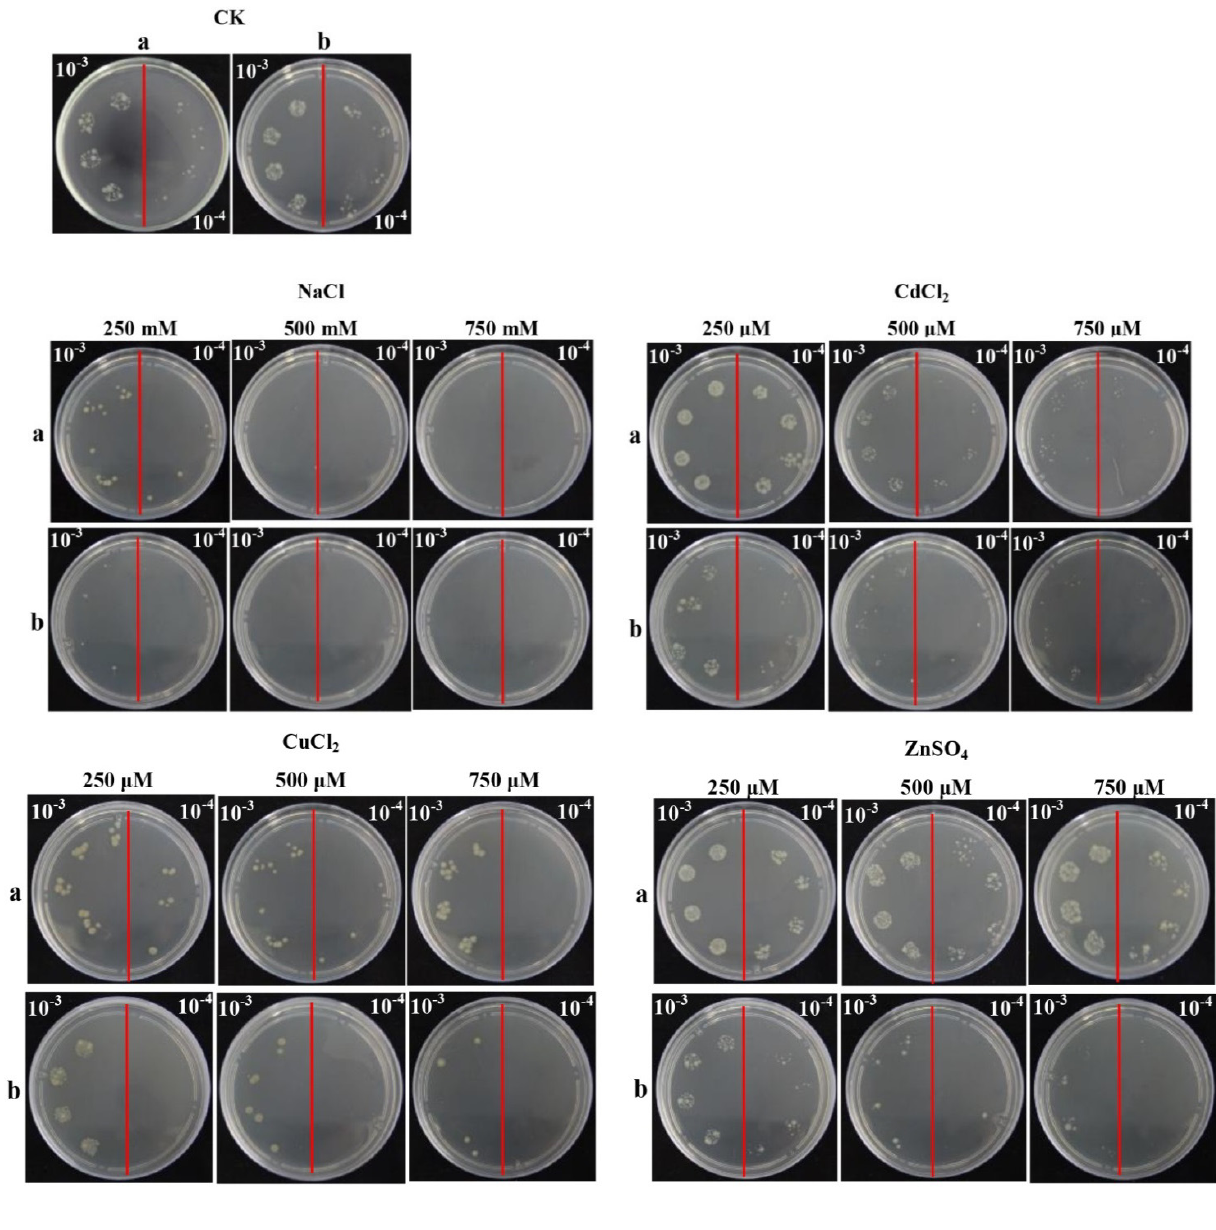
Figure 7. Spot assays of Rosetta + pET 32a- ScChi ( a ) and Rosetta + pET 32a (control) ( b ) on Luria-Bertani (LB) plates with NaCl, CuCl , CdCl and ZnSO . Isopropyl 2 2 4 β - D -thiogalactoside (IPTG) was added to the cultures of Rosetta + pET 32a- ScChi and Rosetta + pET 32a to induce the expression of recombinant protein. The cultures were = 0.6. Ten microliters from 10 − 3 (left side of the red line on the plate) to adjusted to OD 600 10 − 4 (right side of the red line on the plate) dilutions were spotted onto LB plates without any supplement (CK) or with NaCl (250, 500 and 750 mM), CuCl (250, 500 and 750 μ M), 2 (250, 500 and 750 μ M) and ZnSO (250, 500 and 750 μ M), respectively. NaCl, CdCl 2 4 sodium chloride; CuCl , copper chloride; CdCl , cadmium chloride; ZnSO , zinc 2 2 4